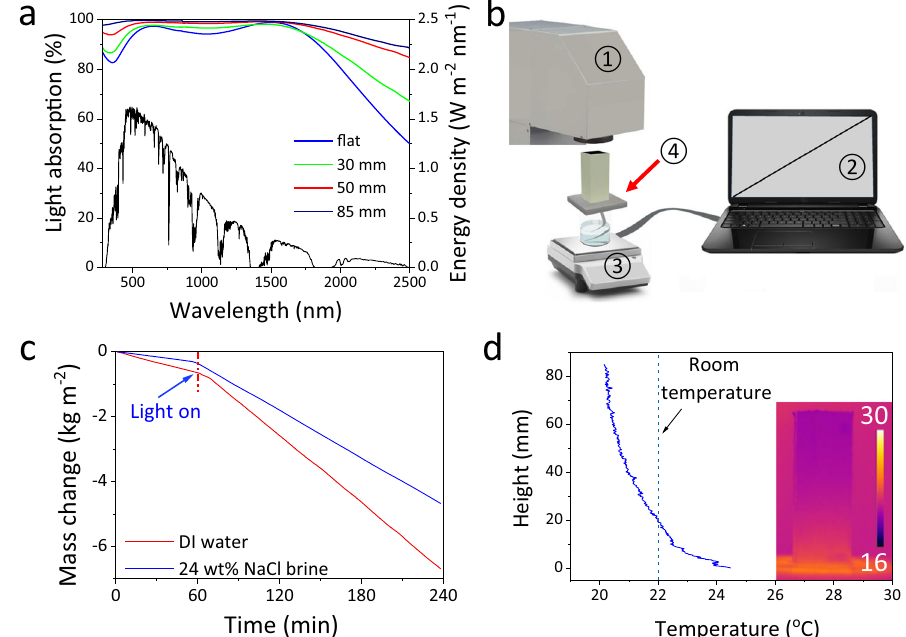
Fig. 2 Evaporation performance of solar crystallizer. a The absorption spectra of the 3D solar crystallizers with different wall heights across 250 – 2500 nm, and standard AM 1.5 G solar spectrum; b the scheme of the labmade setup for solar evaporation performance measurement (1. Solar simulator, 2. computer, 3. electrical balance, 4. solar crystallizer); c the mass change curves of pure water and 24 wt% NaCl by the solar crystallizer under one sun illumination; d the outer surface temperature pro fi le along the wall height of the 3D solar crystallizer in wet state under one sun